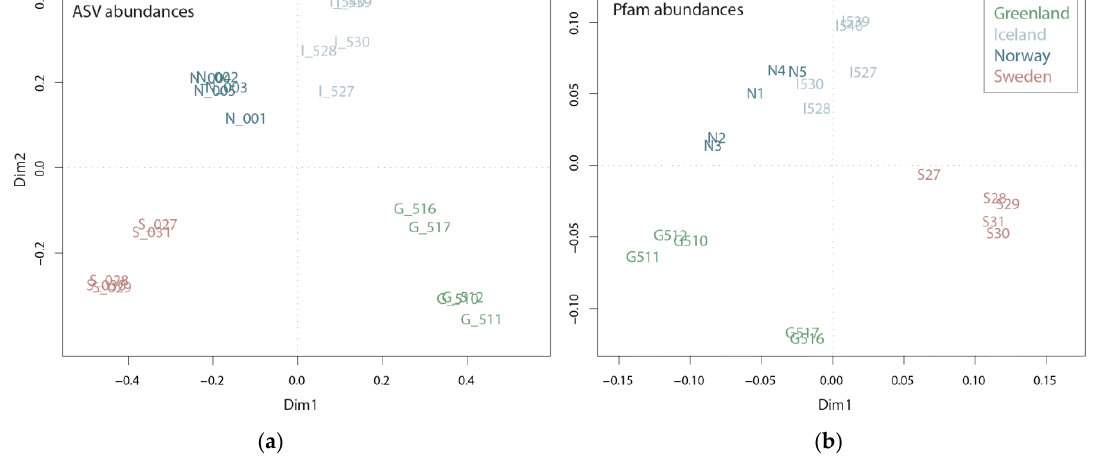
Figure 2. Plots of principal coordinate analysis of amplicon sequence variants (ASV) abundances ( a ) and Pfam domain abundances ( b ) among the sampling sites Greenland, Iceland, Norway and Sweden.